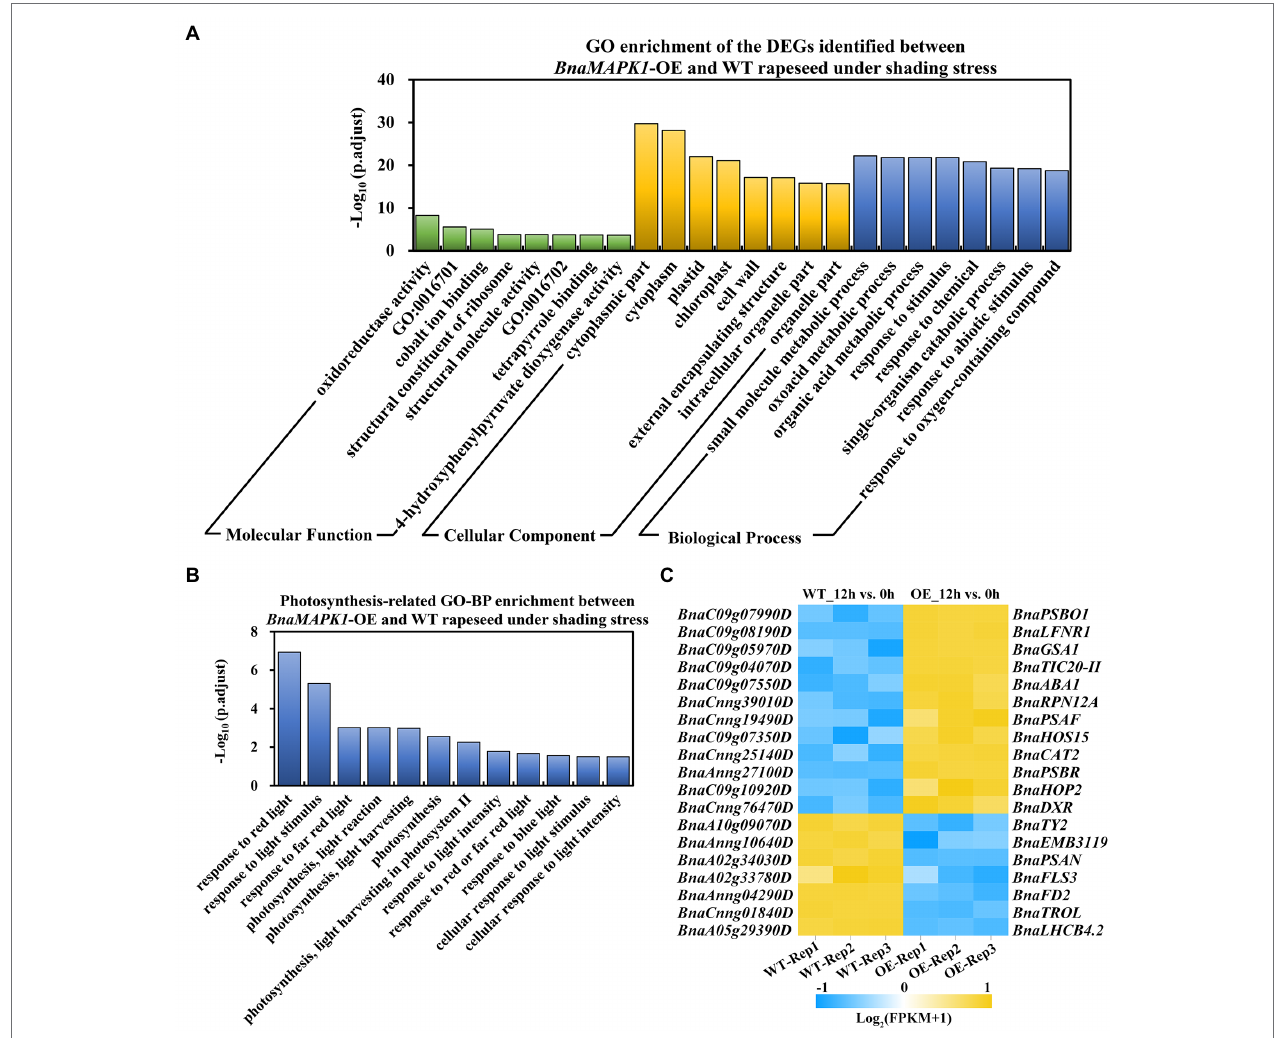
FIGURE 4 | Significantly enriched GO pathways of DEGs in BnaMAPK1 -OE and WT rapeseed under shading stress. (A) Distribution of top eight significantly enrich GO pathways in the 3,000 DEGs in 12h_OE vs. WT group ( p.adjust < 0.05). GO categories included molecular function, cellular component, and biological process. GO:0016701, oxidoreductase activity, acting on single donors with incorporation of molecular oxygen; GO:0016702, oxidoreductase activity, acting on single donors with incorporation of molecular oxygen, incorporation of two atoms of oxygen. (B) GO analysis of DEGs involved in photosynthesis-related biological process